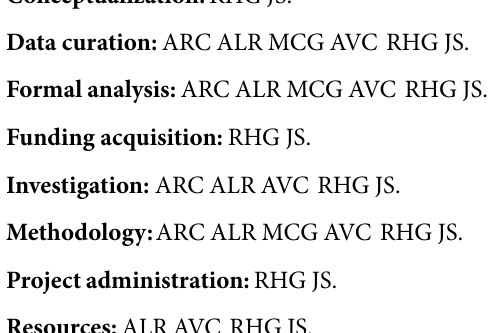
S1 Fig. Electron density map is F − F syntheses(blue) contoured at 2.2 s for FMN. O C (PNG) S2 Fig. Superimposition of apo Sp Fld (blue) and sulfate anion (magenta-red)with apo fla- vodoxin structures of E . coli MioC (pale blue) (a), Helicobacter pylori (yellow) and chloride anion (green) (b), Anabaena (salmon) and sulfate ion (c). (TIF) S3 Fig. Surface representation of apo (a) and holo form (b) of Sp Fld. Protein is coloured in grey whereas FMN carbon atoms are coloured in white. Note that FMN induces the forma- tion of a larger pocket in the holo form (in which FMN locates) in comparison with a smaller pocket present in the apo structure. S4 Fig. Sp Fld size and purity analyses by 12% SDS-PAGE; line 1: molecularmass markers, line 2: Sp Fld at the end purification